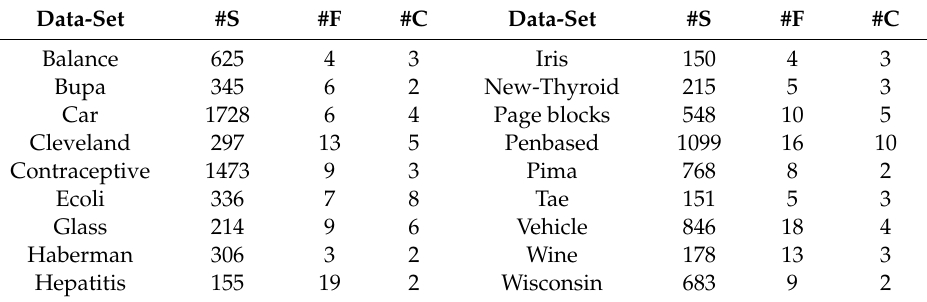
Table 4. Description of the benchmark data sets.